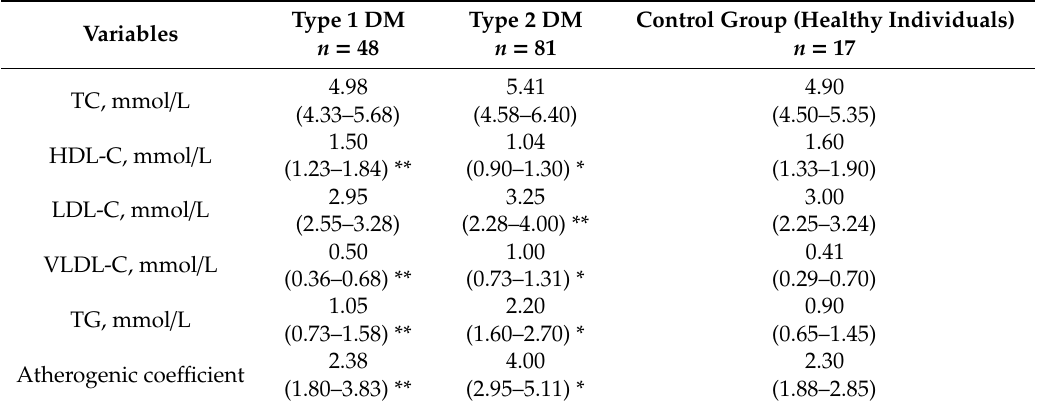
Table 3. Comparative characteristics of the lipid profile in patients with DM and in the control group.